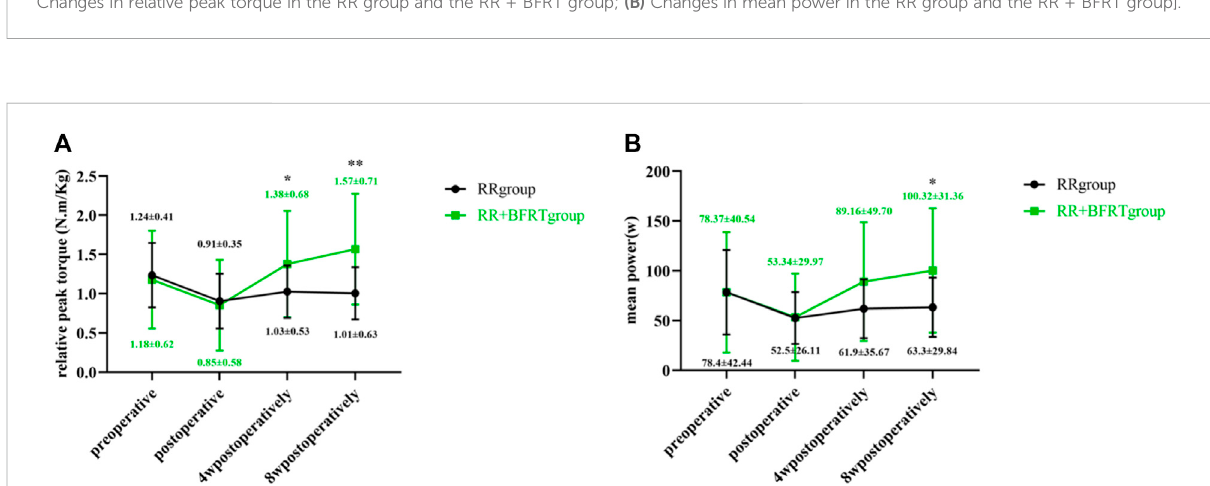
FIGURE 5 Comparison ofrelativepeaktorque andmeanpower between RRgroup andRR+BFRT groupatdifferenttime points. “ * ” indicatesasigni fi cant change( p < 0.05). “ ** ” indicatesasigni fi cantchange( p < 0.01).Valuesarepresentedasmean±SD.RRGroup:routinerehabilitationgroup;RR+BFRT Group: routine rehabilitation + blood fl ow restriction training group. [ (A) : Comparison of relative peak torque between RR group and RR + BFRT group; (B) Comparison of mean power between RR group and RR + BFRT